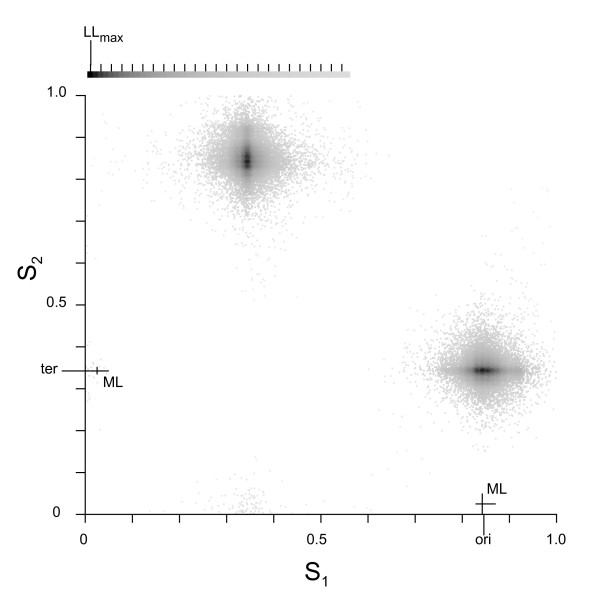
Likelihood surface for the E. coli K12 chromosome. This representation of the likelihood surface of the E. coli K12 chromosome (NC_000913) is based on the MOBS model (see Methods). The two axes represent relative chromosome length so that every point represents the likelihood analysis on the pair of chromosome locations [S1, S2]. The grey scale inset shows the conversion of log likelihood to grey value, with the maximum log likelihood (LLmax) as black and the bars indicating -10 decrements. Since not every pair of chromosome locations was sampled the points are dispersed. The likelihood analysis is symmetrical around the diagonal so the two maxima are identical and represent just one pair of chromosome locations, but interchanging leading and lagging strands. The negative lines represent the location of the annotated ori and ter. The positive lines represent the maximum likelihood (ML) values and Monte Carlo estimated 95% ranges.